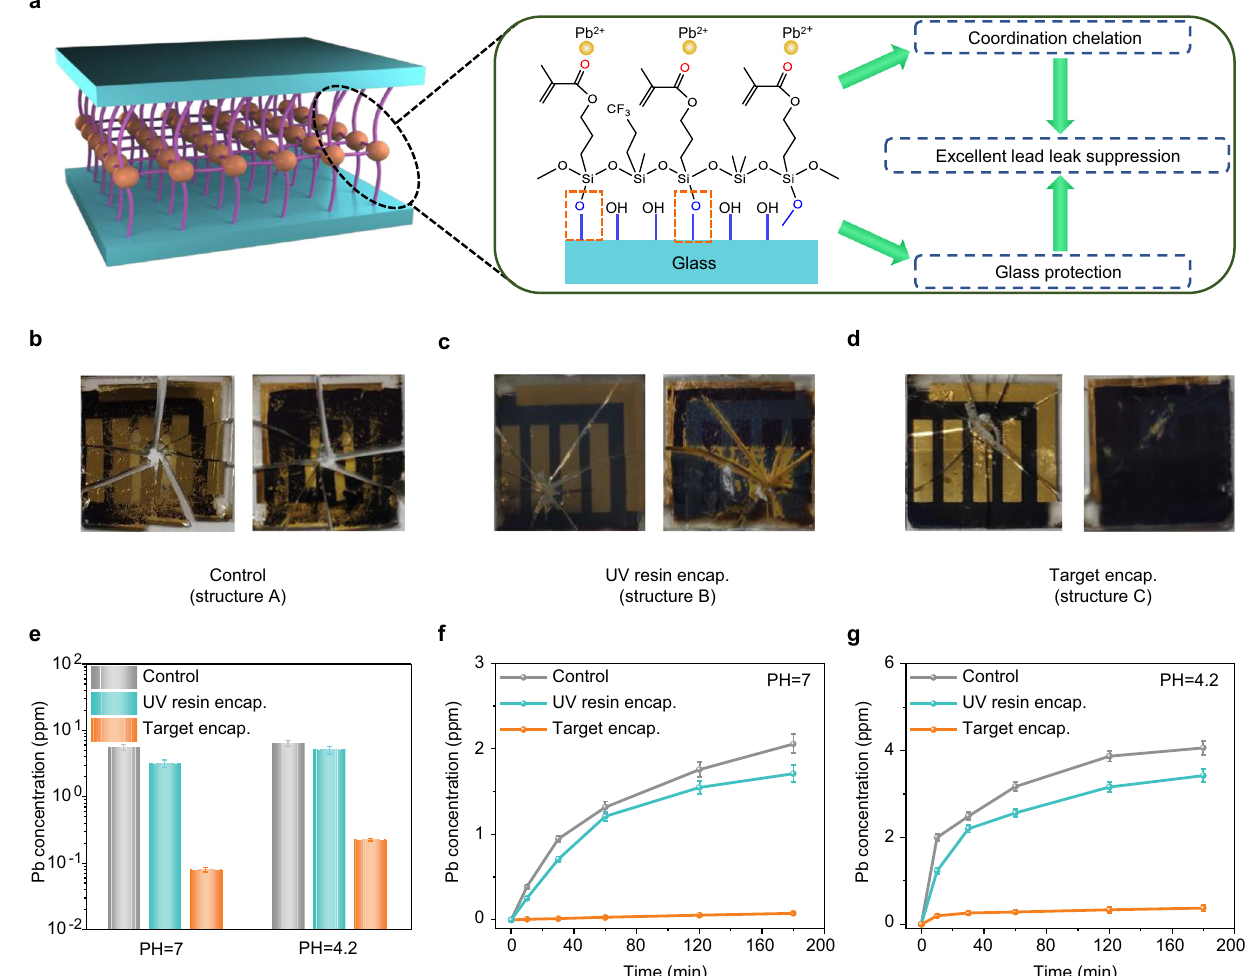
Fig. 4 | Lead sequestration in the PSCs with target encapsulation. a Illustration of lead leakage suppression via excellent glass protection and the strong coordi- nation interaction between C=O groups and Pb 2+ . b – d The typical process for the preparation of damaged PSCs for lead leakage test is based on b the unencapsu- lated PSCs, c the PSCs with UV resin encapsulation, and d the PSCs with target encapsulation. e Water-dripping test results for the damaged PSCs without